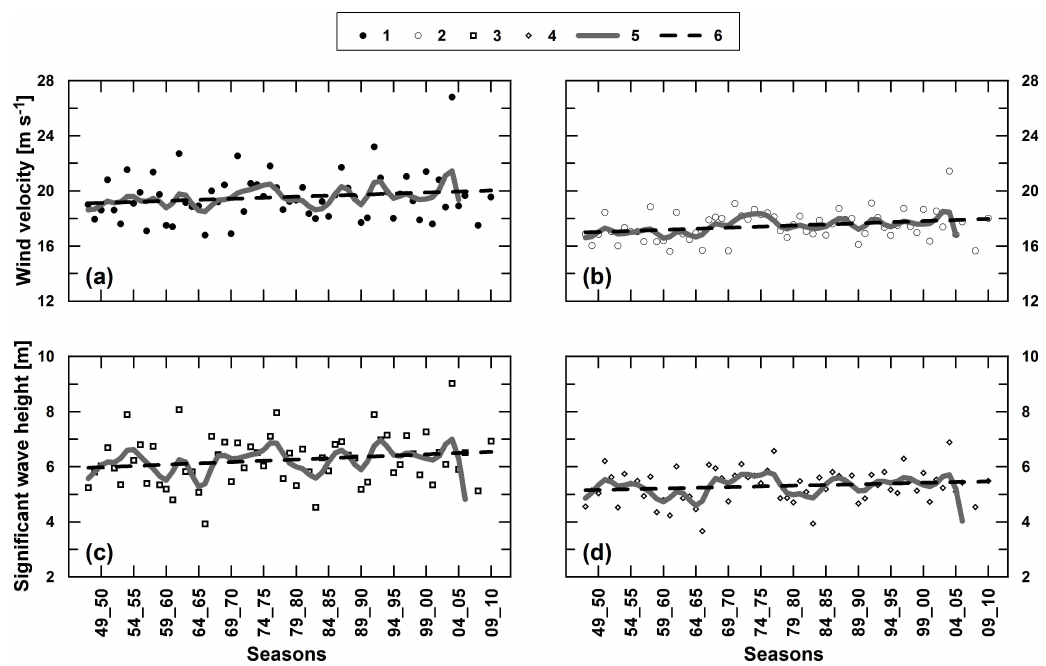
Fig. 7. Variability of average maximum and average mean over the storms’ second phase values of wind velocity and significant wave height during 1948–2010; (a) average maximum wind velocity: 1 – data points, 5 – LPF approximation, 6 – global linear trend (0.15ms − 1 decade − 1 , R 2 = 0.023); (b) average mean wind velocity of the II phase: 2 – data points, 5 – LPF approximation, 6 – global linear trend (0.16ms − 1 decade − 1 , R 2 = 0.071); (c) average maximum significant wave height: 3 – data points, 5 – LPF approximation, 6 – global linear trend (0.09mdecade − 1 , R 2 = 0.032); (d) average mean significant wave height of the II phase: 4 – data points, 5 – LPF approximation, 6 – global linear trend (0.05mdecade − 1 , R 2 =